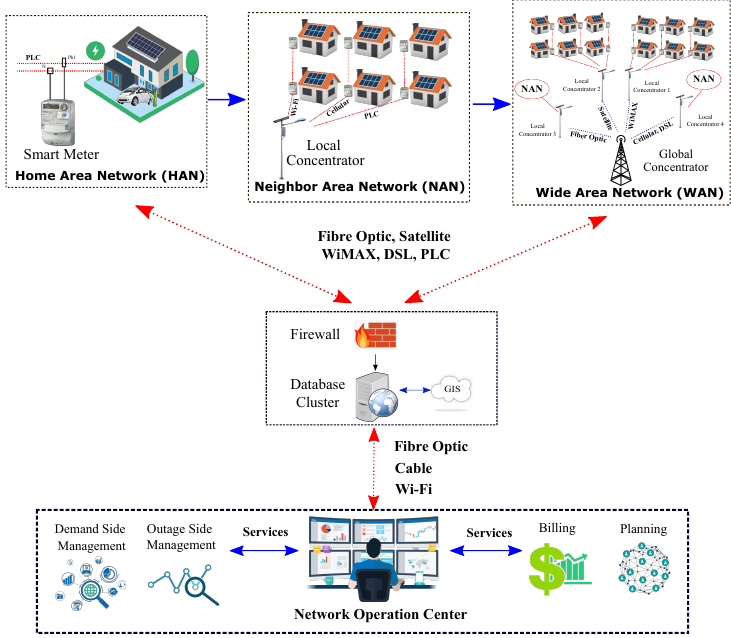
Figure 3. Smart Meter Architecture Diagram (adapted from Reference